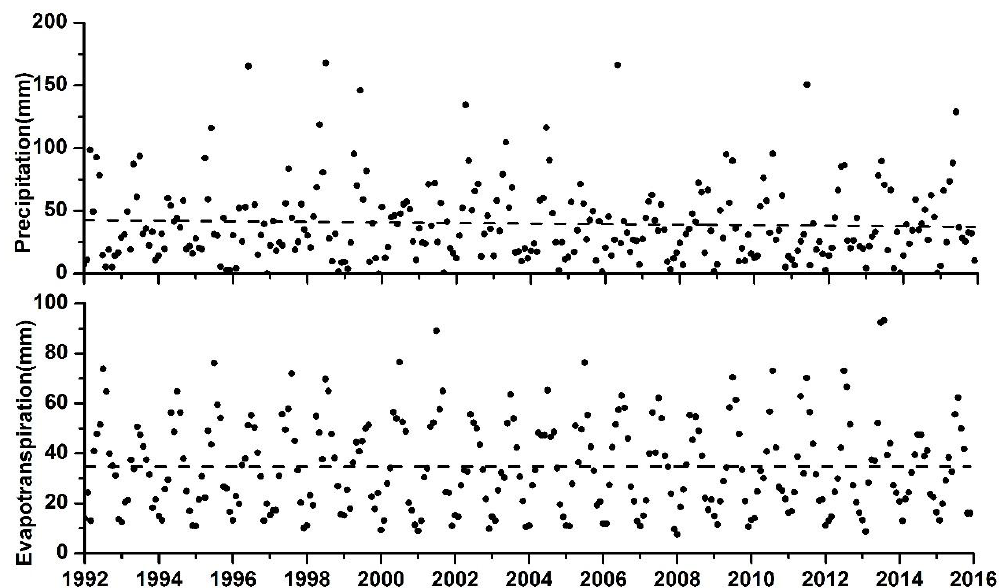
Figure 8. The long-term precipitation and evapotranspiration in the Tian-e-Zhou oxbow lake between 1992 and 2015. The linear fitting line did not show an obvious synchronous change of the two climate factors.